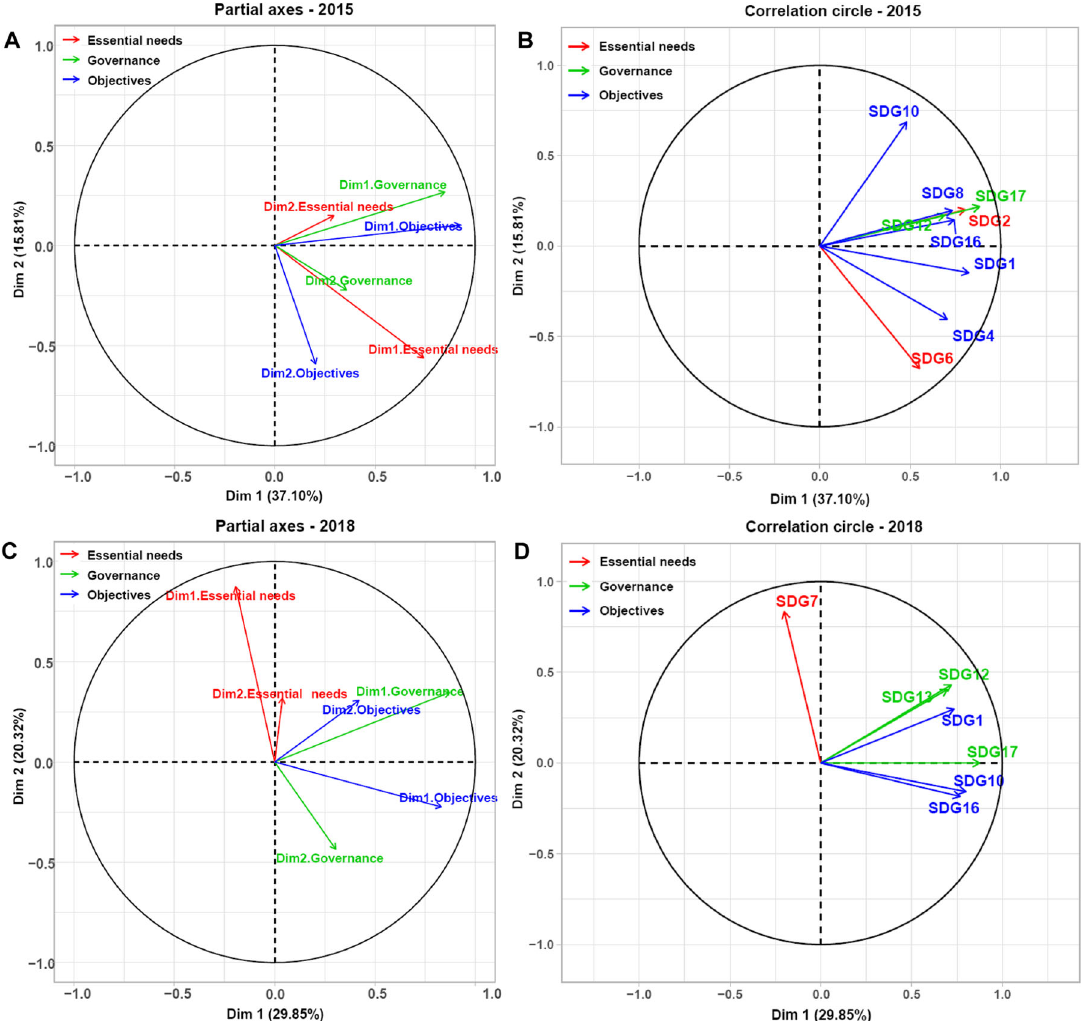
Fig. 3 Interactions among different SDG categories and the goals that signi fi cantly affect different interactions in China. A Partial axes: Interactions among different SDG categories in 2015. B Correlation circle: Goals that signi fi cantly in fl uence interactions among different SDG categories in 2015. C Partial axes: Interactions among different SDG categories in 2018. D Correlation circle: Goals that can signi fi cantly in fl uence interactions among different SDG categories in 2018. The partial axes re fl ect the principal components of different data groups in the global principal component analysis, which indicate general characteristics of interaction across the three SDG categories. Correlation circles reveal the SDGs that have a signi fi cant effect in each category. Among the three SDG categories, “ Essential Needs ” consists of SDG2 (Zero Hunger), SDG6 (Clean Water and Sanitation), SDG7 (Affordable and Clean Energy), and SDG15 (Life on Land); “ Objectives ” includes SDG1 (No Poverty), SDG3 (Health and Well-Being), SDG4 (Quality Education), SDG5 (Gender Equality), SDG8 (Decent Job and Economic Growth), SDG10 (Reduced Inequalities) and SDG16 (Peace, Justice and Strong Institutions); “ Governance ” includes SDG9 (Industry, Innovation, and Infrastructure), SDG11 (Sustainable Cities and Communities), SDG12 (Responsible Production and Consumption), SDG13 (Climate Action) and SDG17 (Partnerships for the Goals). Please note that SDG14 (Life below Water) is not considered in this (Gender Equality), SDG9 (Industry, Innovation, and Infrastruc- ture), and SDG11 (Sustainable Cities and Communities) generally improved, but there were obvious differences in the extent to which the SDG scores increased in different provinces. Group I